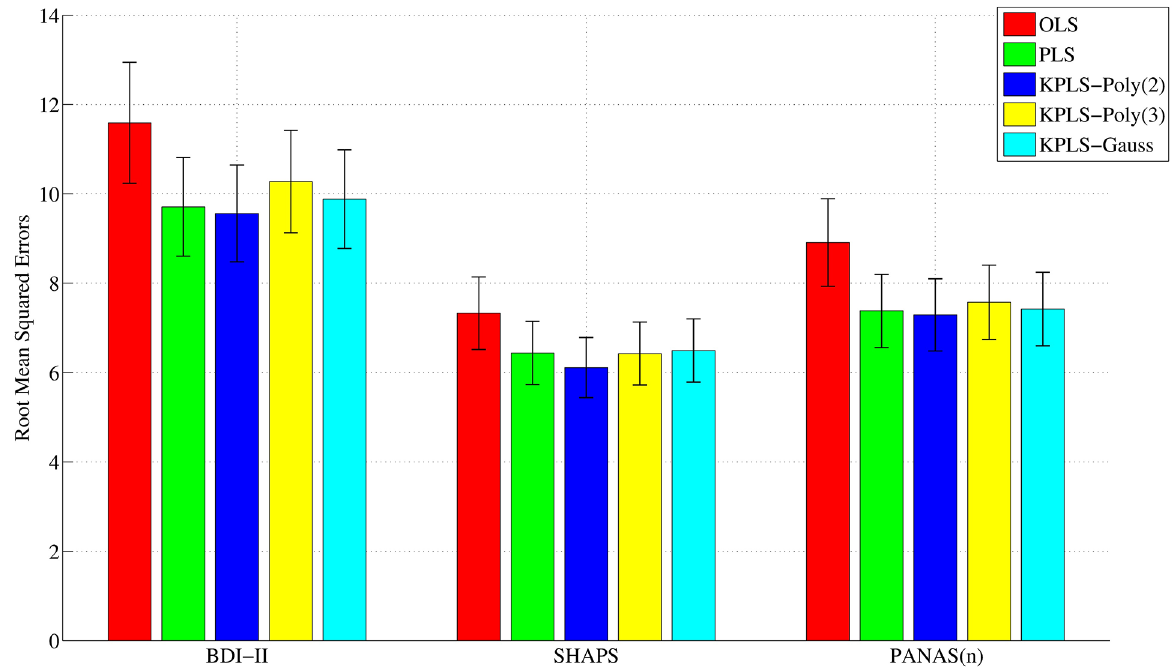
Fig 2. Comparison of predicted performance by means of the root mean squared errors. Linearand kernel variants of PLS achievedsignificantlybetter performance than did OLS in all clinical scores. Subject age was used as the output along with clinical scores